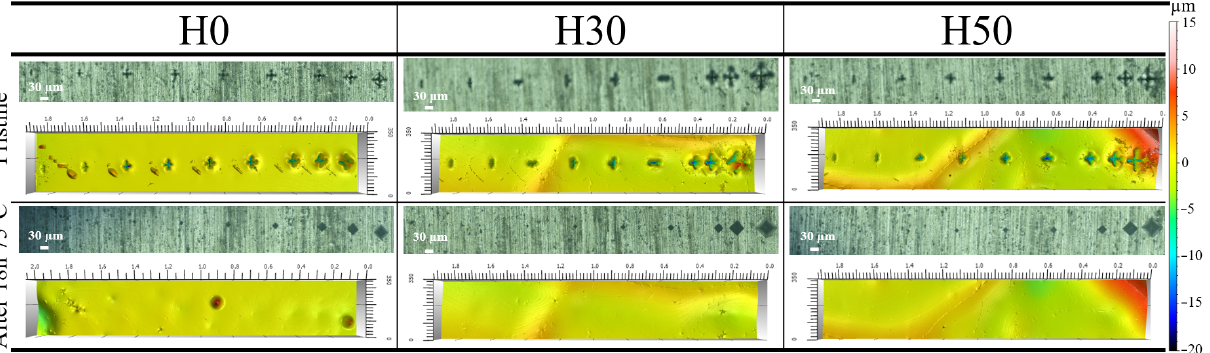
treatment of 18 h at 75 °C. After healing scratches on hybrid H30 and H50 coatings are fully closed, while the substrate is still exposed at some parts of H0 coating. Like for in- denter marks, scratch imprints on the substrate are still visible through coatings but inter- ferometric surface studies confirm the recovery of their surface relative flatness. Those tests confirm previous statements but comparison between samples is more difficult be- cause of the differences between initial scratches morphology. Hybrid materials seems to have faster healing properties, but this observation needs to be considered carefully be- cause of the original scratch diensions’ differences. As the profile extracted from surface data shown in red in Figure S2 exhibits, H50 coatings are capable of healing wounds as wide as twice its thickness. Figure 10. Optical and interferometric surface analysis results of scratched coatings before and after 18 h at 75 °C. 3.3. Anticorrosive Properties of Coatings The protection against corrosion of these coatings were investigated using EIS after their immersion in 0.05 M NaCl solution. This concentration was chosen in order to dis- criminate the behaviors of the different coatings. Bode plots of H0, H30 and H50 at differ- ent immersion times are presented in Figure 11a–c respectively, with impedance points represented in filled symbols and phase angle in hollow ones. Analyses were conducted every 24 h of immersion, from 0 h to 168 h. The three coatings show high impedance val- ues above 10 6 Ω .cm 2 at low frequencies at 0 h immersion. Two time constants can be seen in the phase angle plot, one at 5.10 2 Hz and another around 0.5 Hz. They can be ascribed, respectively, to the responses of the coating and of the oxide layer at the interface coat- ing/substrate. As reported in the literature [31,32] those spectra profiles indicate the rela- tive permeability of the coatings to the electrolyte, probably because of its chemical com- position. Moreover, in the case of H0, a low-frequency (0.05 Hz) time constant appears